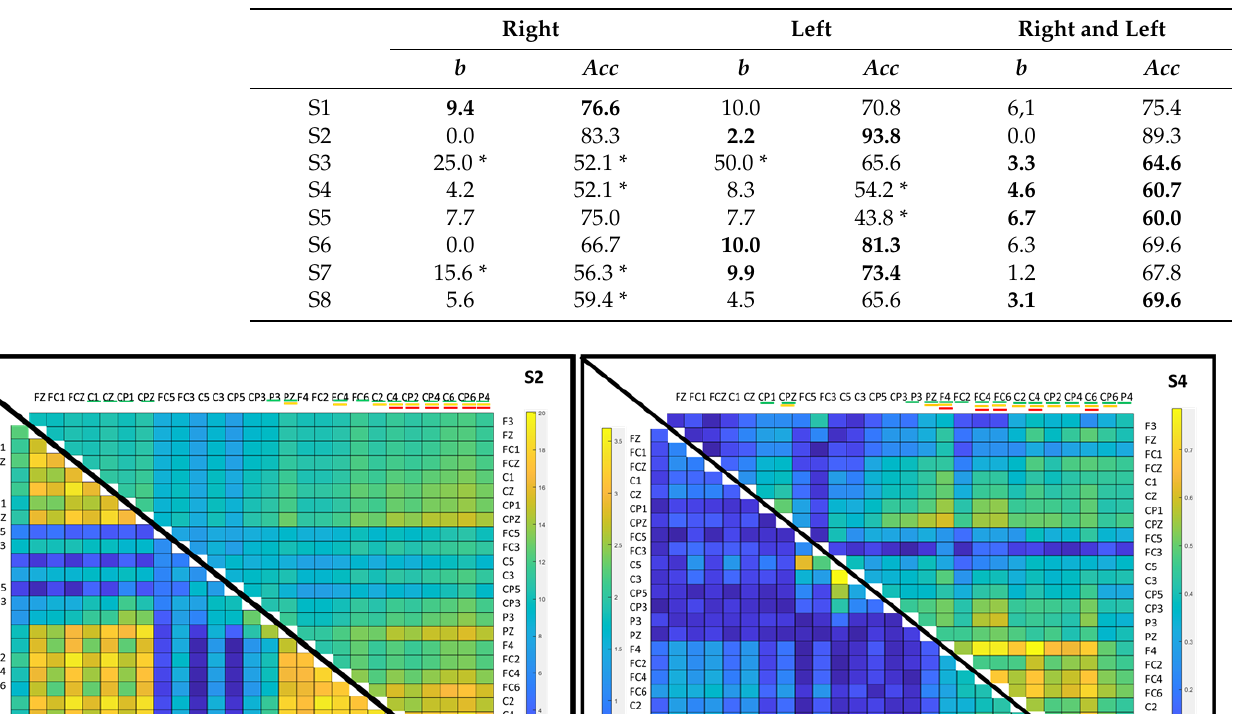
Table 5. Table with each type of model: for only right turn, only left turn and Both. Asterisk indicates that it did not pass the criterion of valid result. In bold, the best configurations.